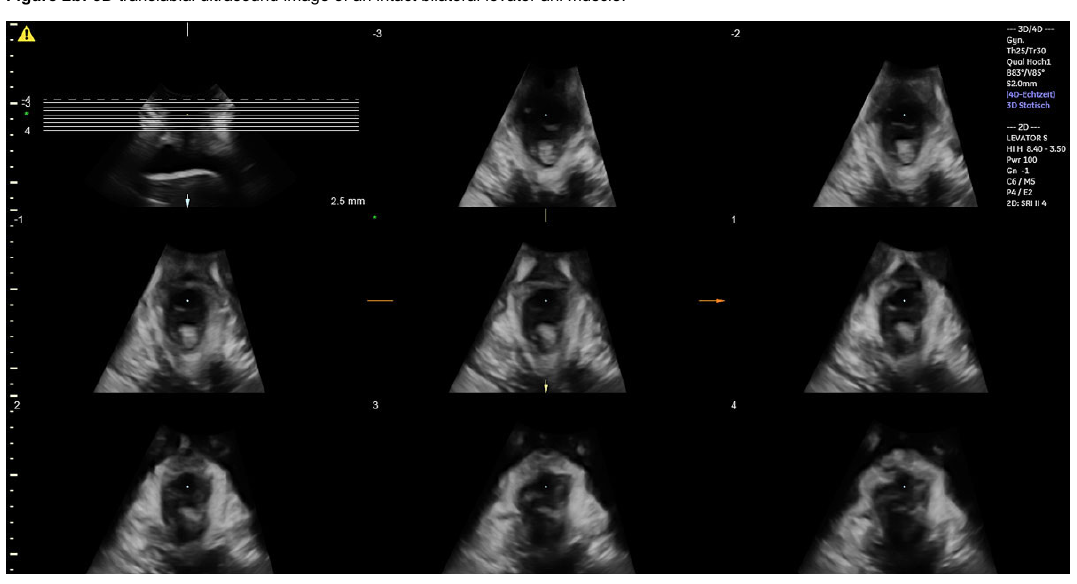
Figure 2b: 3D translabial ultrasound image of an intact bilateral levator ani